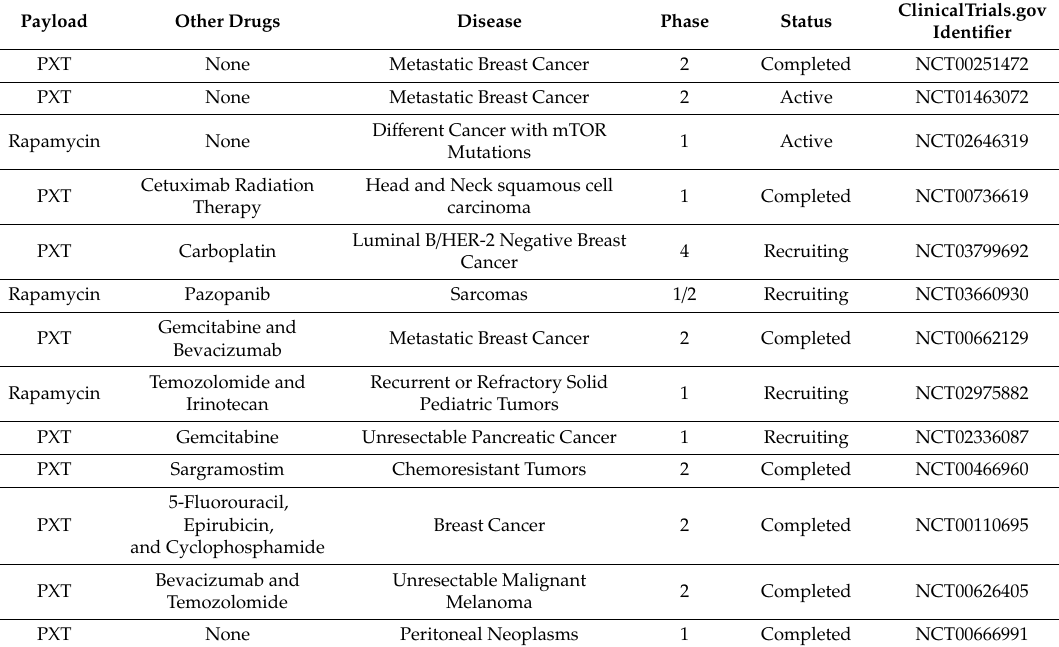
Table 1. Active and completed clinical trials based on albumin nanovector (ANV) treatment for cancer.